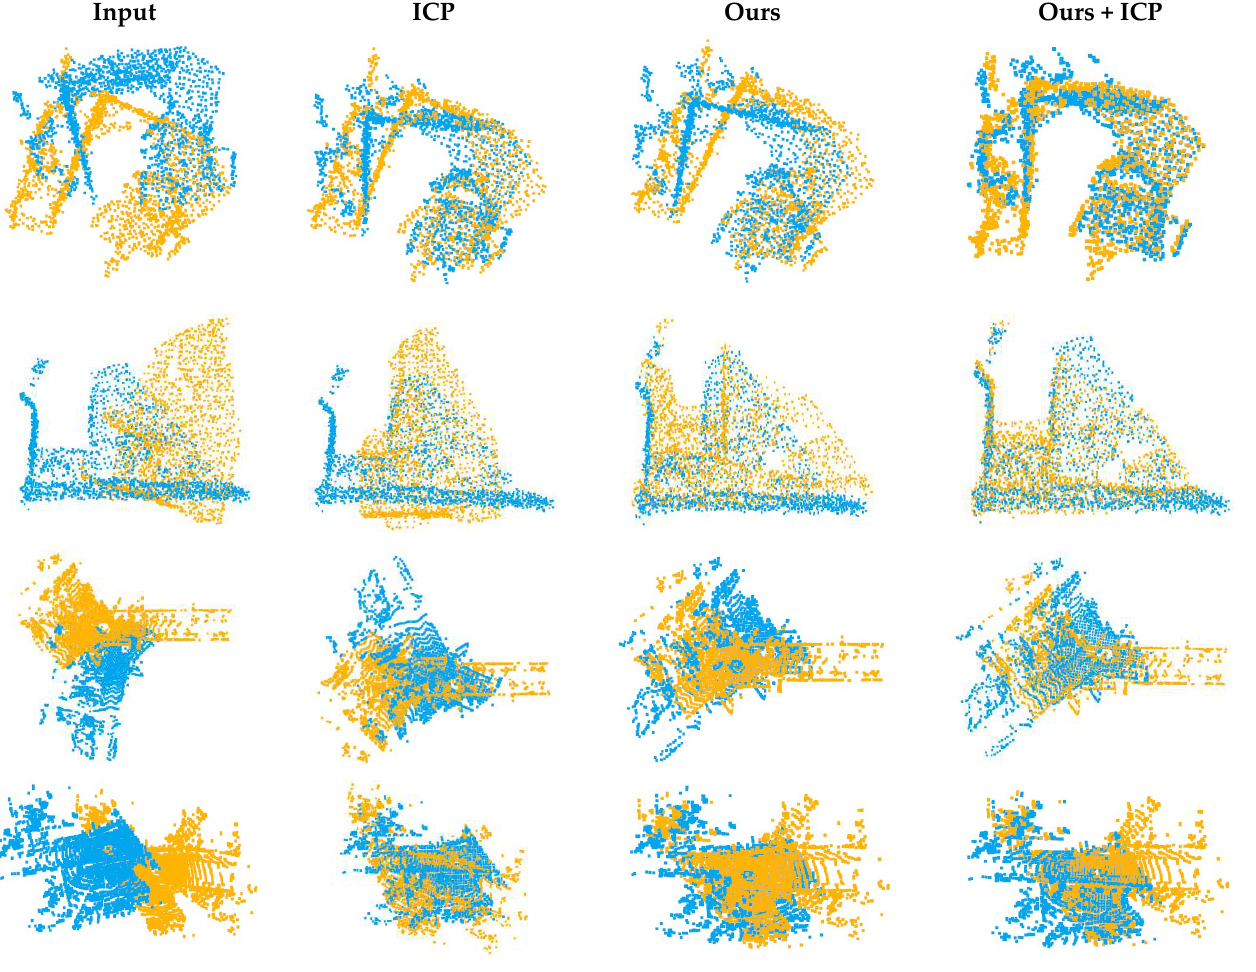
Figure 12. Registration results of 3DMatch and KITTI data.